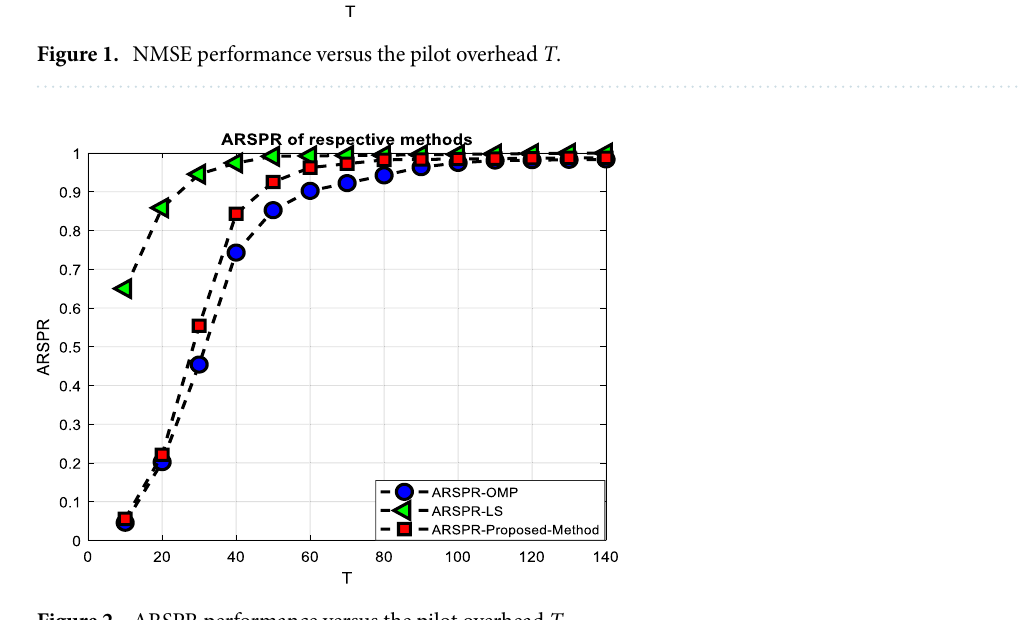
Figure 2. ARSPR performance versus the pilot overhead T